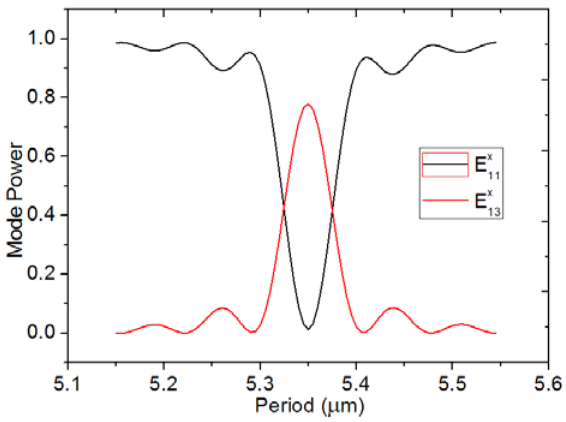
Figure 3. Schematic of a long period grating coupler.